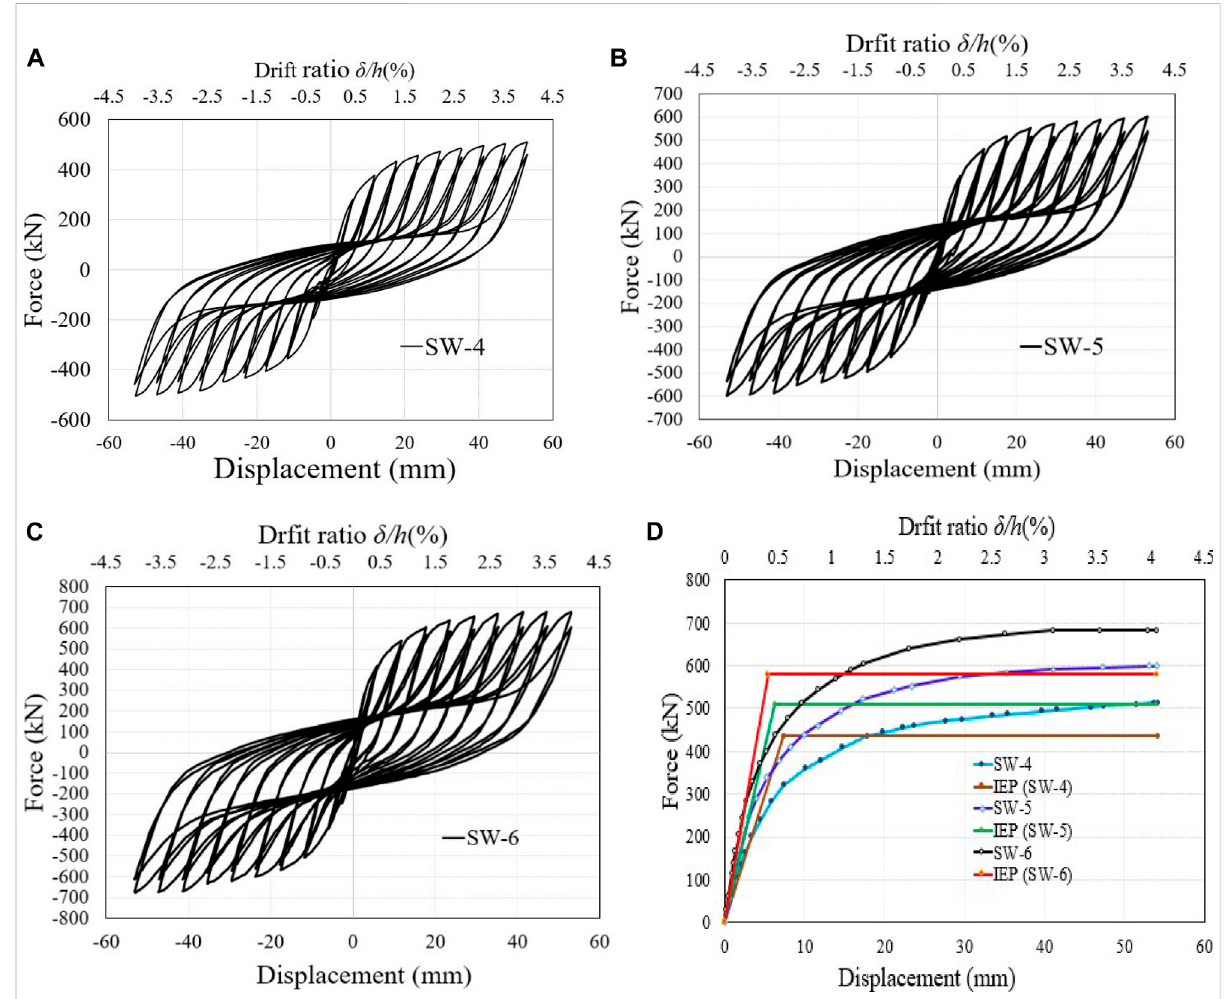
FIGURE 23 The FE model's hysteresis, pushover, and IEP curves are (A – C) Hysteresis, (D) Pushover, and IEP curves.